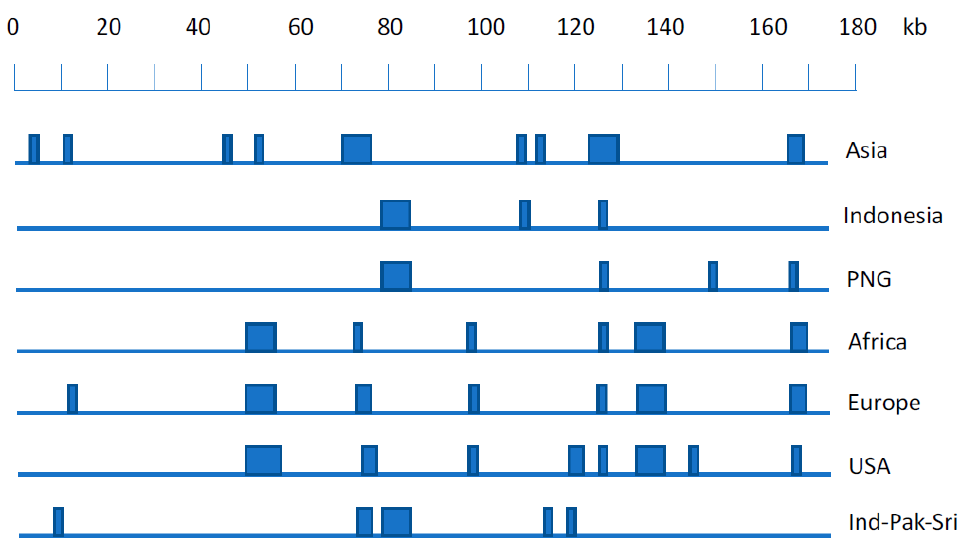
Figure 1. Schematic showing EBV genome locations containing SNPs characteristics for geographic origins of EBV on a scale of the reference NC007605 EBV genome. Vertical bars represent genomic positions of SNPs or haplotypes that are geographic location-specific. Exact details of SNPs specific for each geographic location are given in Table S3 of [23], (details of Ind-Pak-Sri locations will be published elsewhere, but are available on request). PNG is Papua New Guinea; Ind-Pak-Sri is India, Pakistan, Sri Lanka.